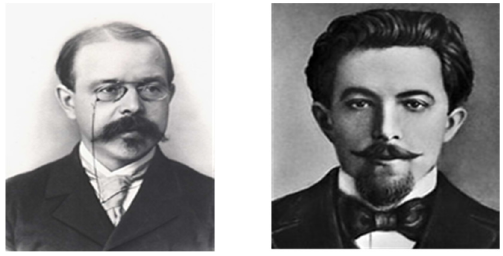
Figure 1. The fathers of physicochemical separation techniques W. Nernst (1864–1941) and M.S. Tswiett (1872–1919).